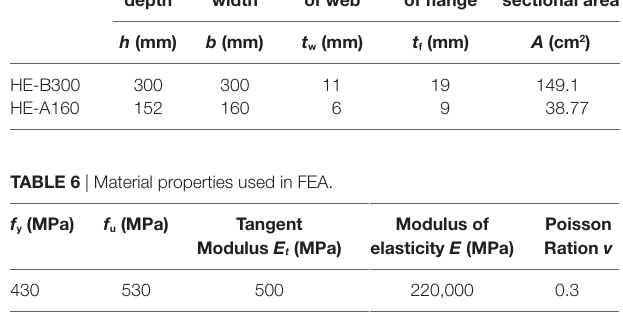
Figure 11 | NA vs EU sections normalized capacity curve comparison for 8-storey frame.